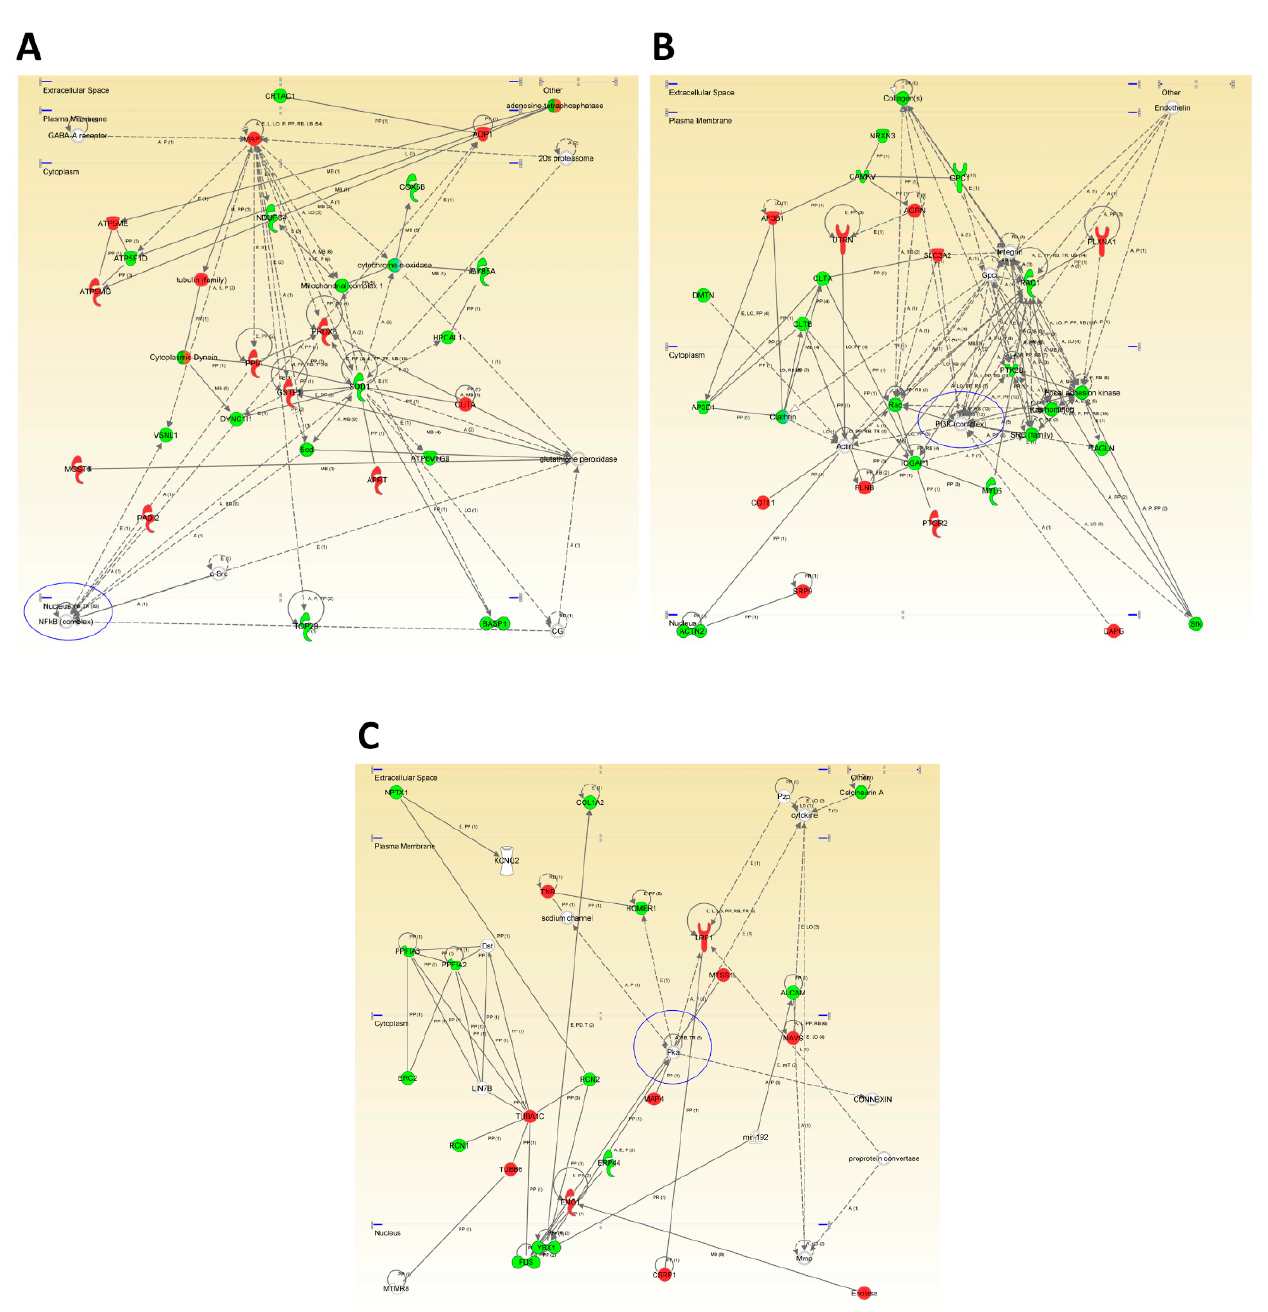
Figure 3. High/scoring protein interactome networks for differential expressed proteins in the OB of MixD subjects. A-C show hubs proposed by IPA software focused in NF κ B ( A ), Pi3K ( B ) and PKA ( C ). Up-regulated and down-regulated.